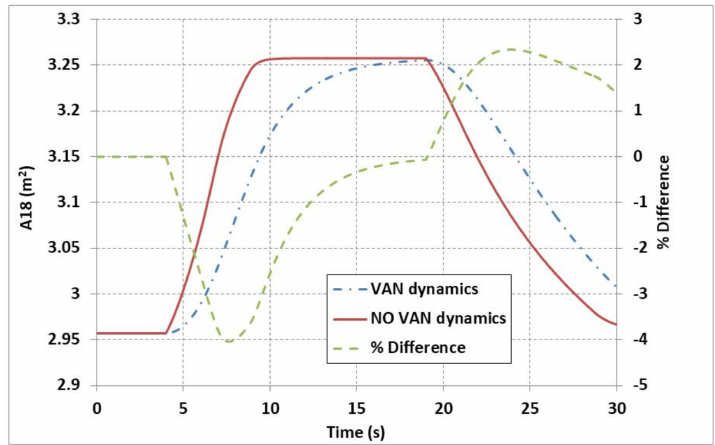
Figure 13. Change in VAN response with VAN